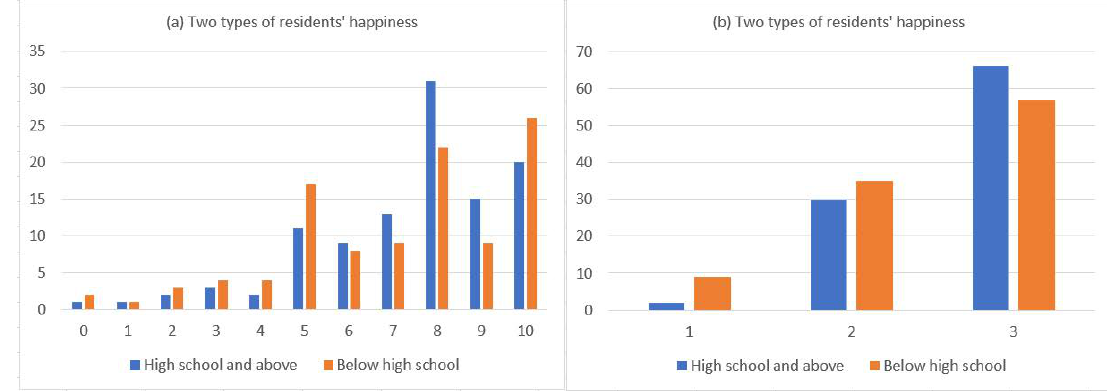
Fig. 1 Comparison of the impact of academic qualifications on happiness scores